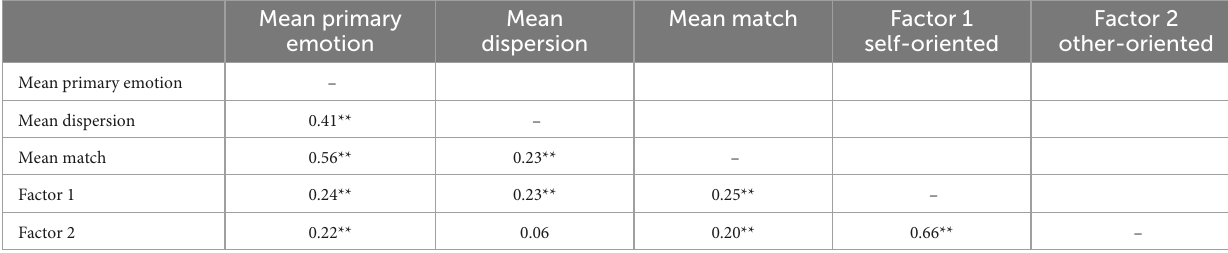
TABLE 4 Pearson correlation coefficients measuring the relationships between the behavioral task measures and the IRI/EI